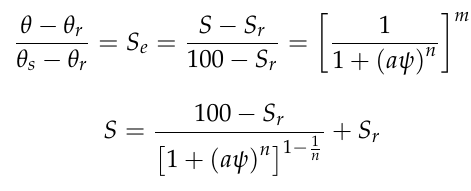
Figure 5. Sample dehumidification curve.